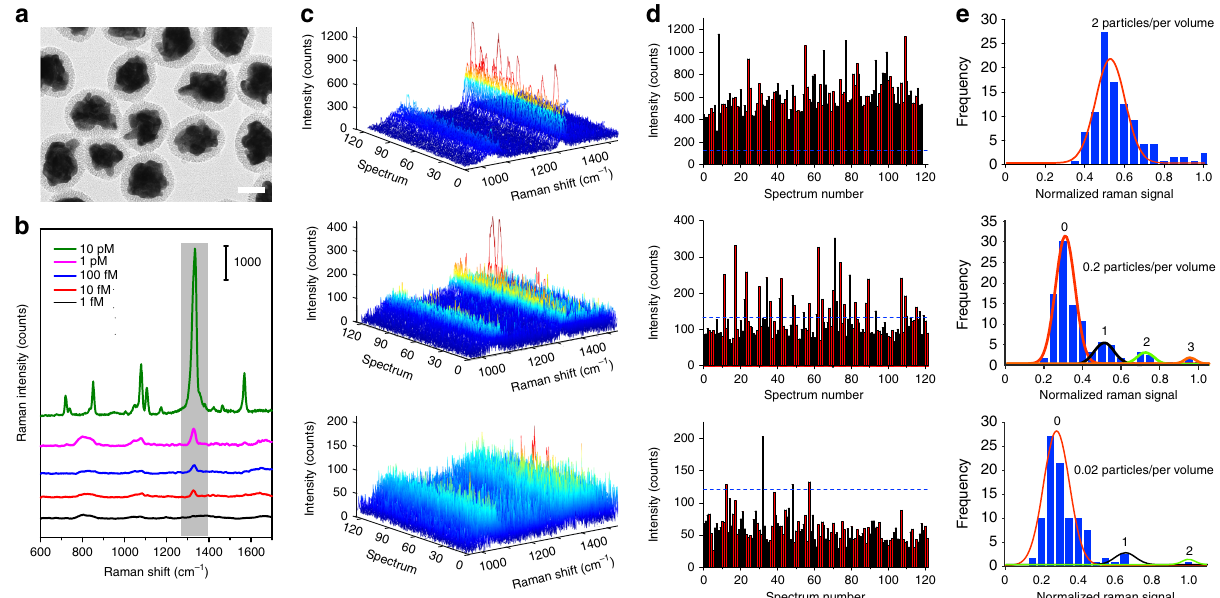
Fig. 3 Single-NP detection of aqueous P-GERT solution. a TEM image of mesoporous silica-coated (MS) P-GERTs. Scale bar is 20 nm. b Concentration- dependent Raman measurements of aqueous MS P-GERTs (638 nm laser, 20 mW, 10 s acquisition time, and ×60 objective lens). c SERS spectra plot, d the intensity of Raman band at 1340 cm − 1 , and e the corresponding statistical analysis of 120 measurements from 100 (top), 10 (middle), and 1 (bottom) fM P- GERT solution. 100, 10, and 1 fM GERT solutions correspond to 2, 0.2, and 0.02 particle per probing volume, respectively. Blue dotted lines in panel d represent the background Raman signal (1340cm − 1 ) without P-GERTs. All solid curves in panel e are Gaussian fi tting to the data. The fi tted peaks show the Gaussian (top) or Poisson (middle and bottom) distribution of the data. For Poisson distribution, the red, black, green and orange peaks re fl ect the probability to fi nd 0, 1, 2, or 3 particles per